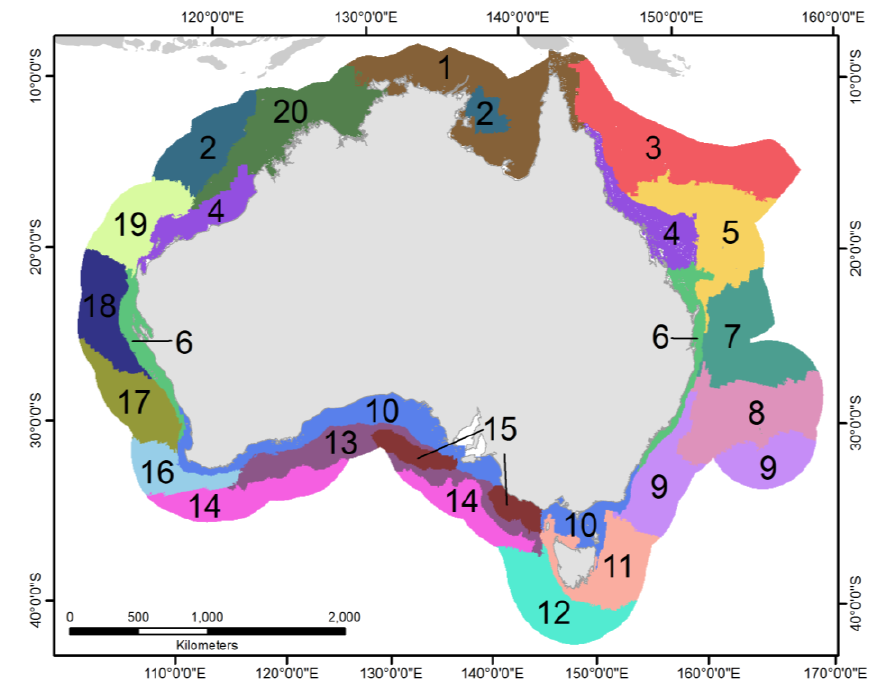
Figure 2. Map of the 20 acoustic zones of the Australian Exclusive Economic Zone (EEZ) for austral winter.